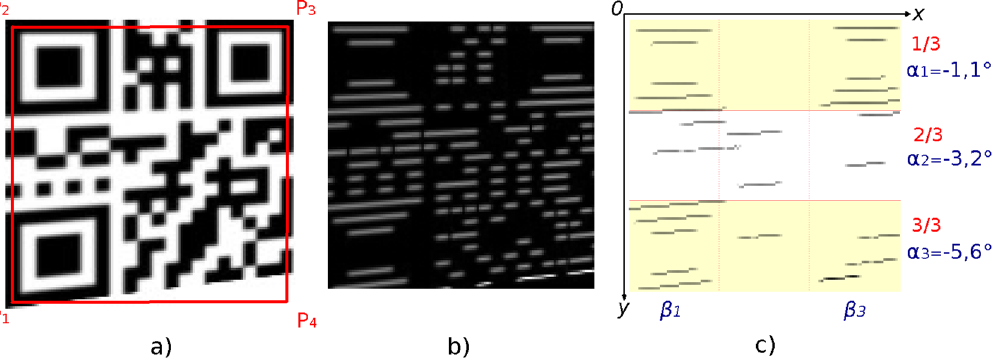
Figure 15. Identification of QR Code distortion by edge orientation analysis: ( a ) QR Code; ( b ) horizontal edges image; ( c ) significant edges.